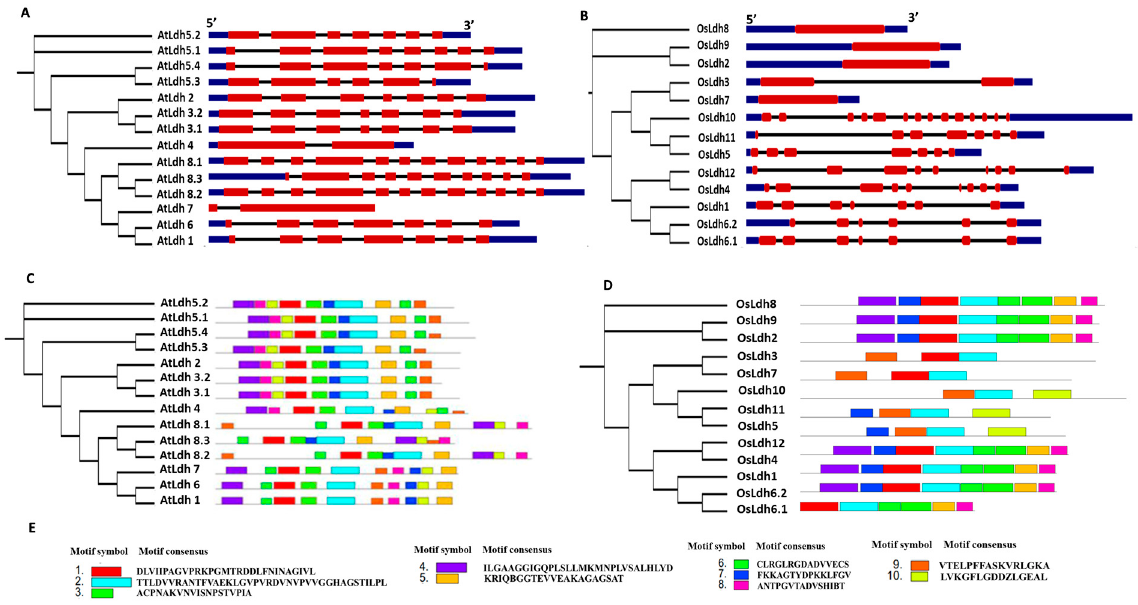
Figure 3. Schematic representation of exon–intron architecture of genes encoding lactate/malate dehydrogenases in model plants Arabidopsis and rice. The exon–intron structures of the genes encoding lactate/malate dehydrogenases in ( A ) Arabidopsis and ( B ) rice were made using the Gene Structure Display Server (GSDS) tool. The exons and introns have been depicted in red and black, respectively, and the UTR regions are depicted in blue. The length of exon and introns are not to scale. Motif organization in ( C ) Arabidopsis and ( D ) rice Ldh proteins analysed using MEME Suite. ( E ) List of consensus motifs identified in rice and Arabidopsis using MEME Suite.